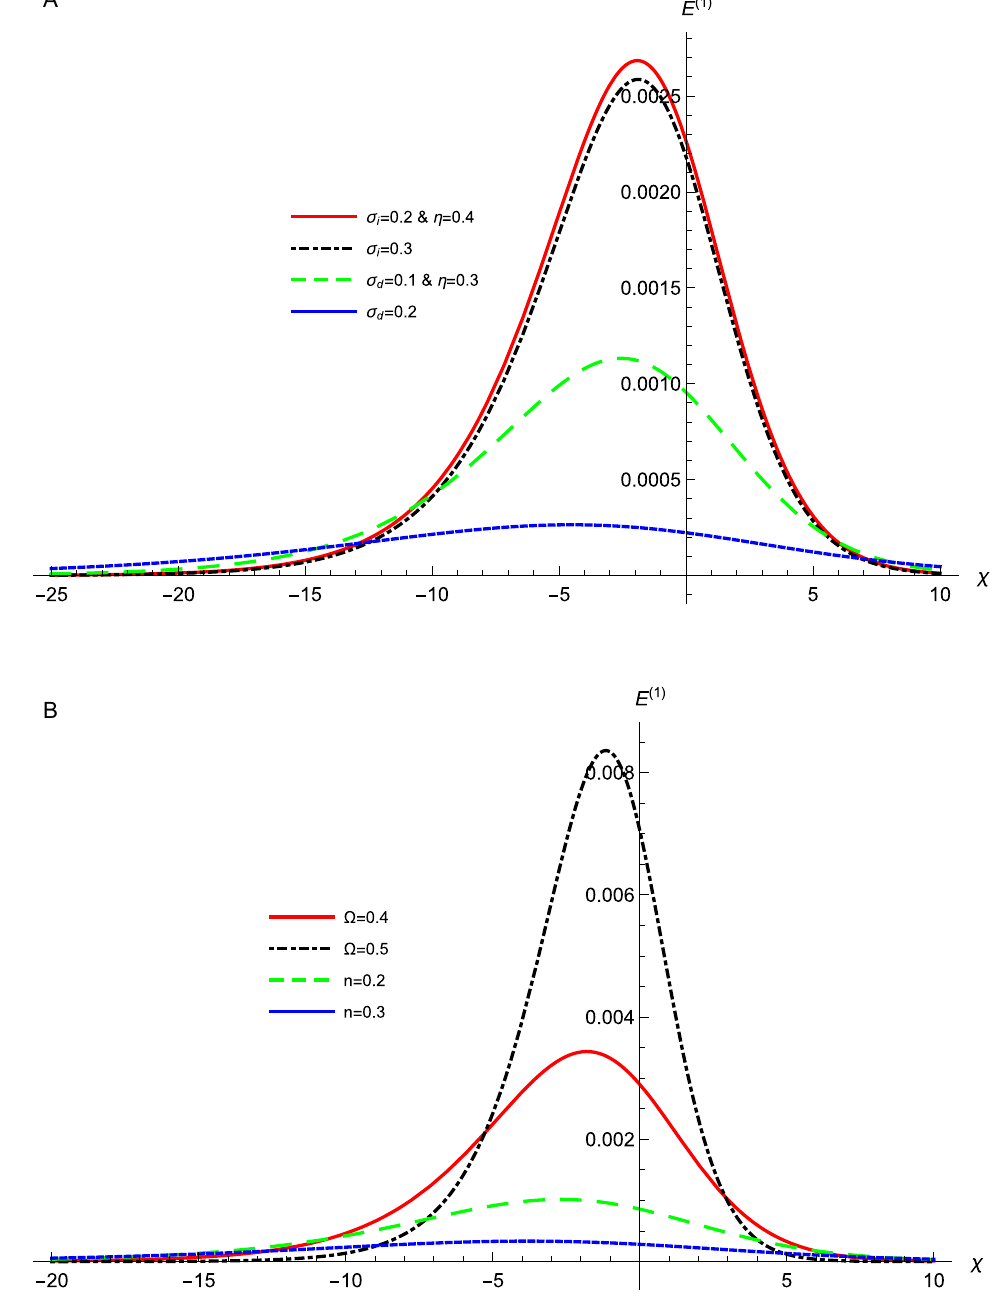
1 ) of DA waves that represented by Eq. (12) with χ for